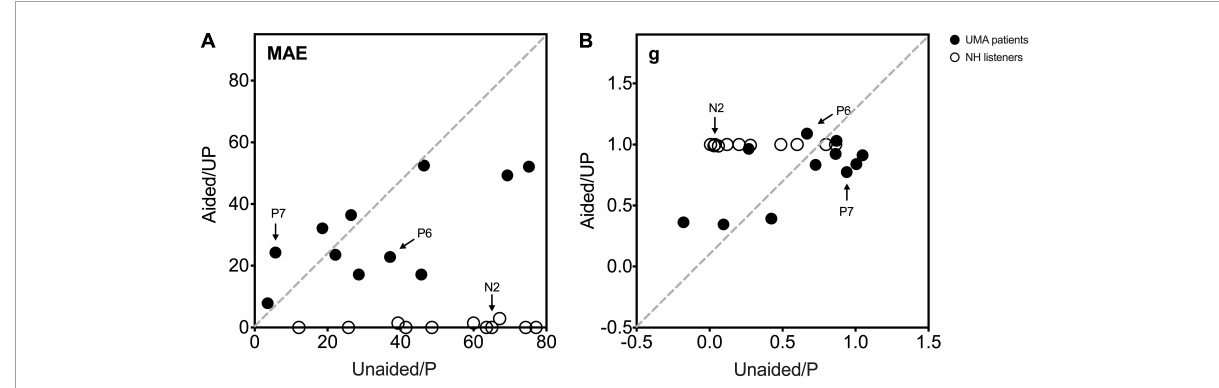
FIGURE5 (A) The MAE and (B) g under monaural listening conditions (unaided and P, Y-axis) are plotted against those under binaural listening conditions (aided and UP, x-axis). Black circle data points indicate 11 UMA children, and white circle data points indicate the controls. The two UMA children and one control depicted in Figure 4 are marked in this figure (P6, P7, and N2). An MAE near 0 and a gain near 1 demonstrate a close-to-normal sound localization performance. Data of participants with the same sound localization performance when listening monaurally and binaurally are displayed on the gray dotted diagonal. A data point below the diagonal in (A) and above the diagonal in (B) represents a better sound localization performance when listening under binaural conditions than under monaural conditions. UMA, unilateral microtia and atresia; NH, normal hearing group; MAE, mean absolute error; g, response gain; Unaided, the unaided condition of UMA; Aided, the aided condition of UMA; P, the plugged condition of controls; UP, the unplugged condition of controls.